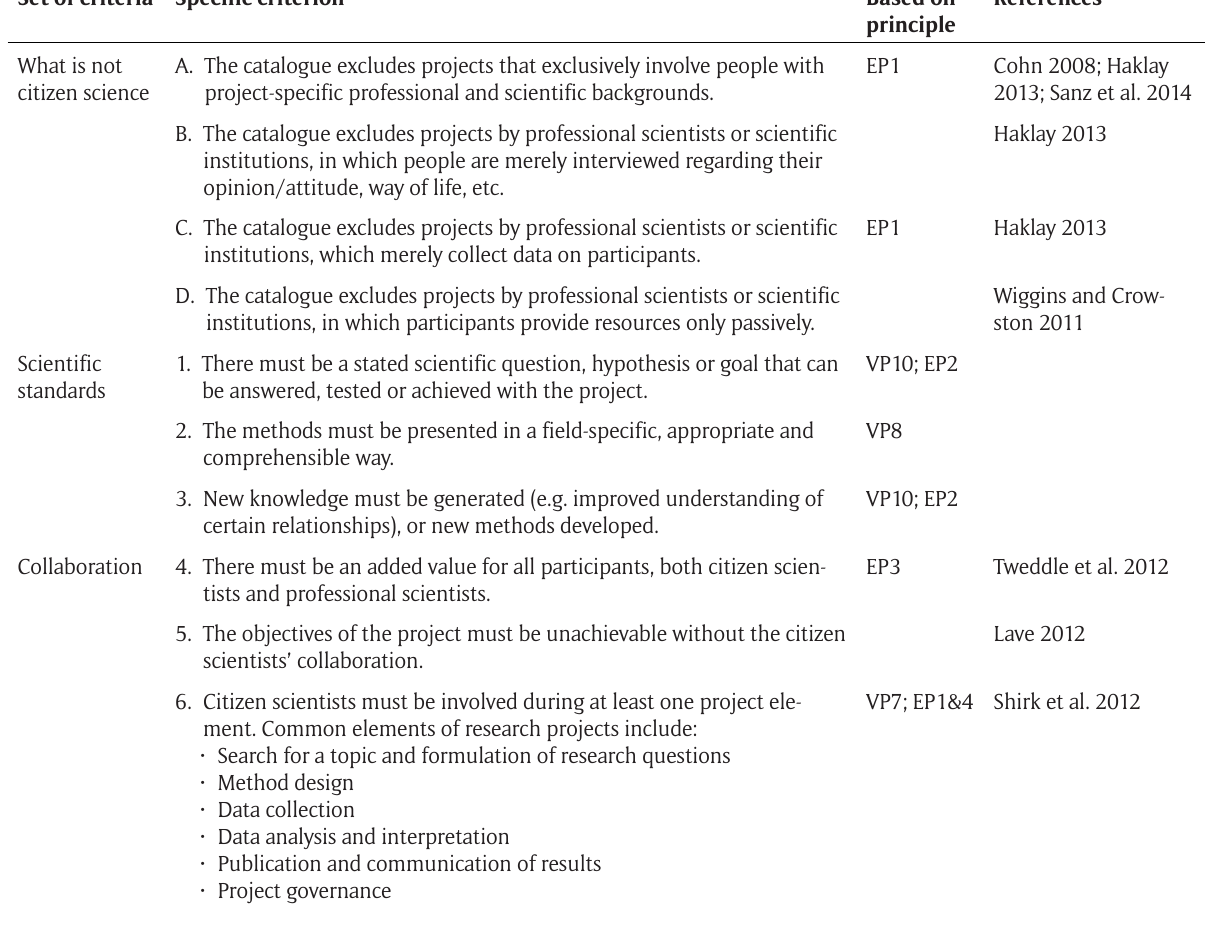
Table 1: Criteria for inclusion in Österreich forscht, their relationship to the ECSA and/or Vienna Principles, and the relevant references that formed the basis of discussions in the meetings of the working group. EP: ECSA Ten Principles of Citizen Science; VP: Vienna Principles: A Vision for Scholarly